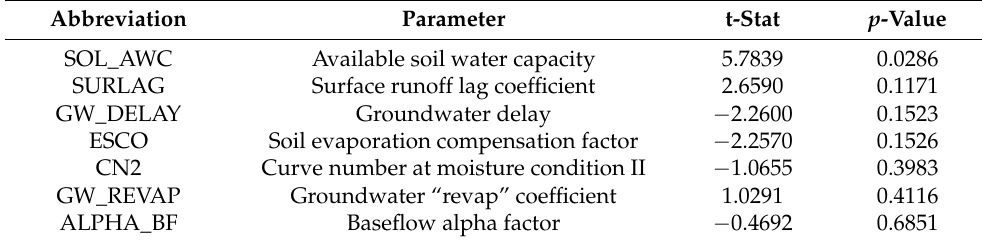
Table 12. SWAT parameter sensitivity to monthly streamflow at the X.191 station.